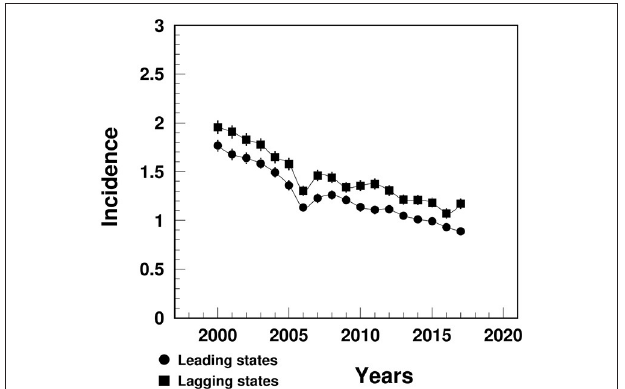
FIGURE 2 | Temporal trend of MI incidence (%) among people aged 65 + in the U.S. leading and lagging states. Note: 1 Data were derived from 5% Medicare Beneficiaries. 2 The sudden decline in 2005–2006 that mainly occurred among females could potential be contributed from the Medicare Policy change (https://www.liebertpub.com/ doi/10.1089/jwh.2012.3777).